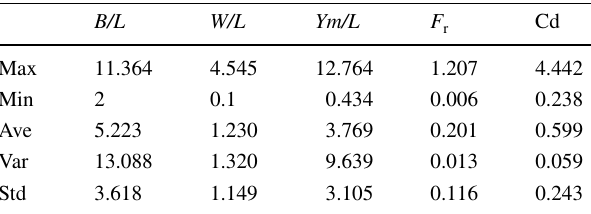
Fig. 1 Layout of experimental models reported by Ojha and Subbaiah (1997) and Hussain et al. (2011)